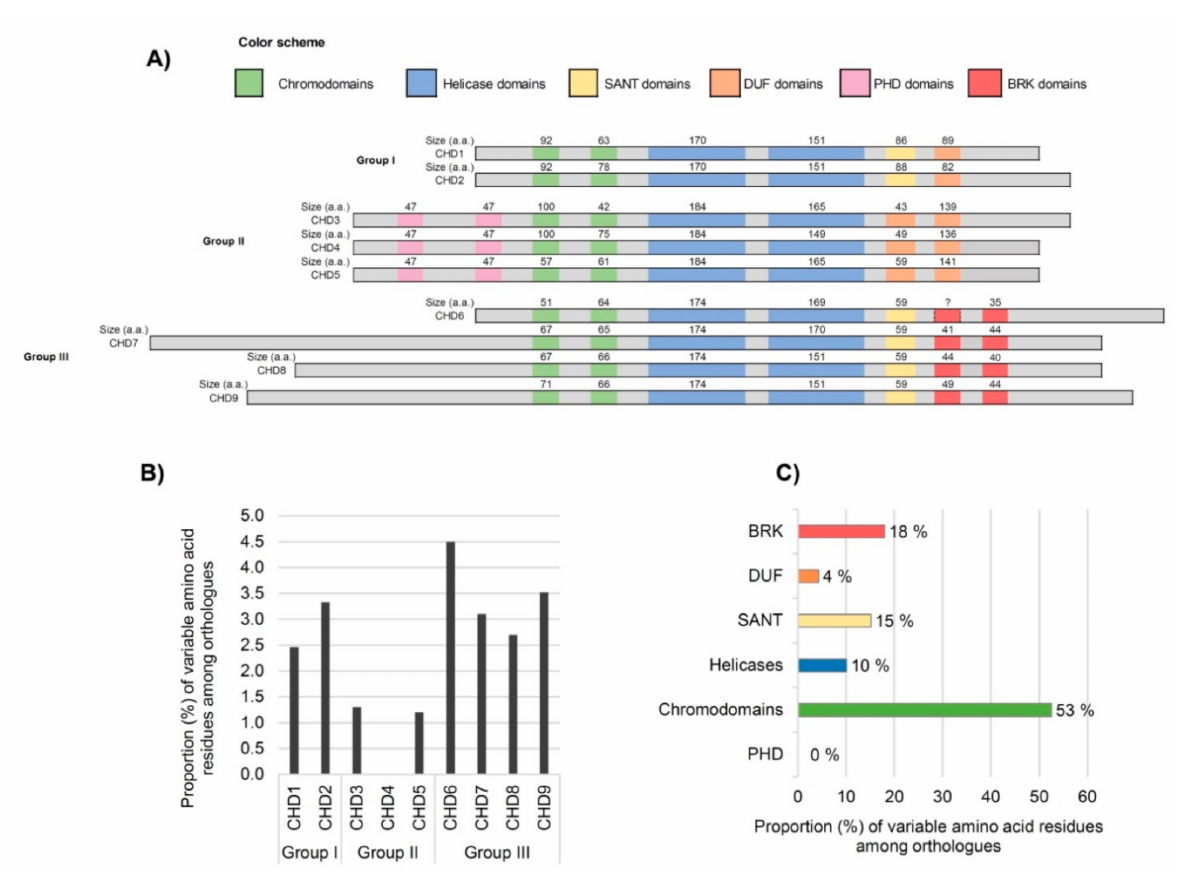
Figure 2. Schematic representation of the architecture of CHD proteins. ( A ) Amino acid (a.a.) size of the conserved domains for each group of CHD paralogues in Homo sapiens . ( B ) Percentage of variable amino acid residues within the functional domains of CHD proteins among orthologues distributed by groups I, II, and III ( n = 139). ( C ) Proportion of variable amino acid residues within the functional domains of CHD proteins among orthologues distributed by categories— Chromodomains, Helicases, SWI3, ADA2, N-COR, and TFIIB (SANT), Domains of Unknown Significance (DUF), Brahma and Kismet (BRK), and Plant Homeodomains (PHD) ( n =